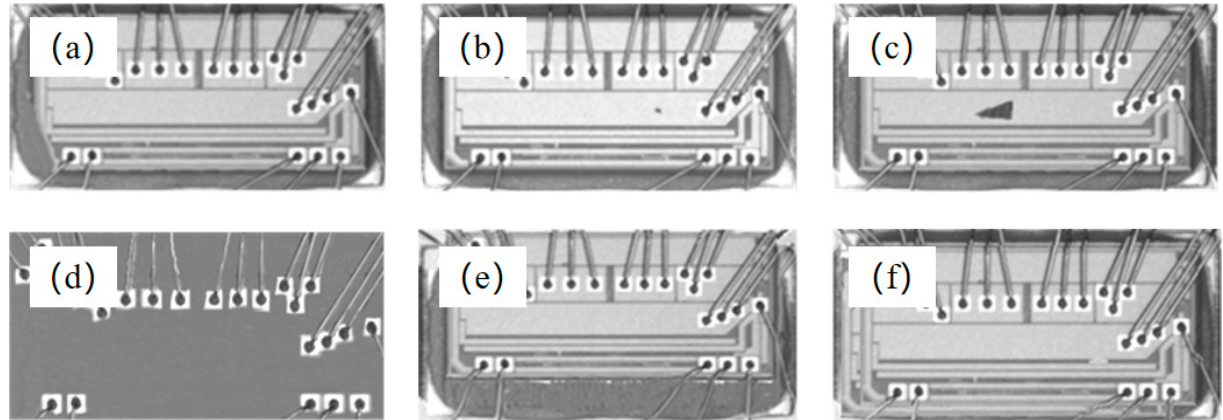
Figure 12. Six types of chip surface defects: ( a ) Edge defect; ( b ) foreign-body defect; ( c ) fragmentation defect; ( d ) void chip defect; ( e ) incorrect position defect; ( f ) repeatedly pasting defect.